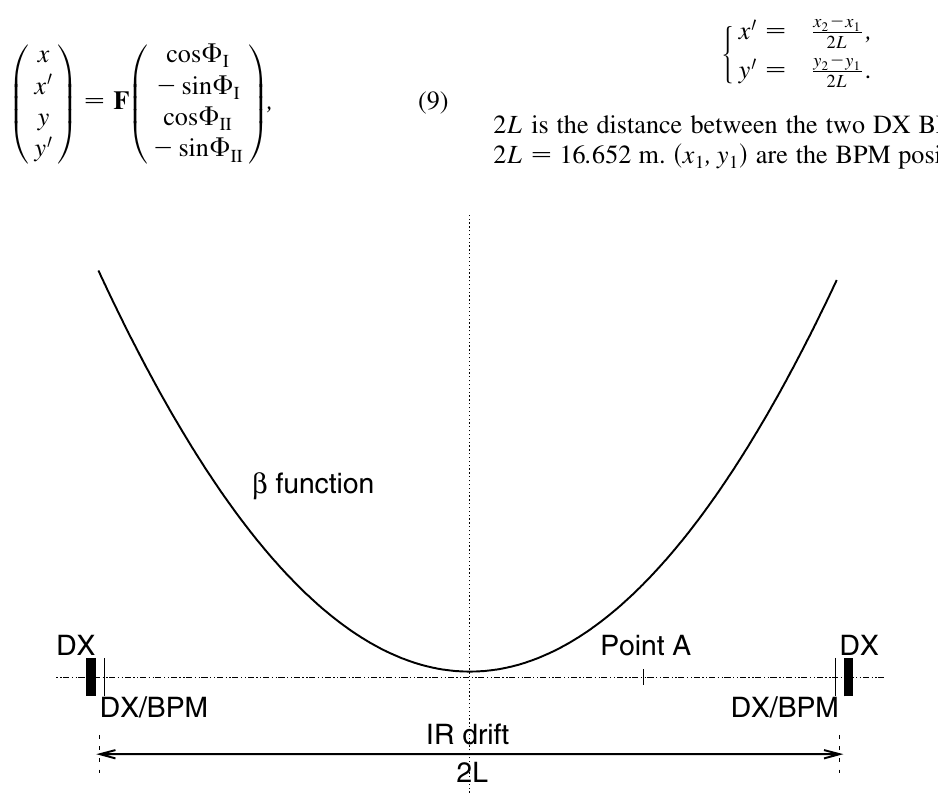
FIG. 1. IR drift between the two DX BPMs in one RHIC